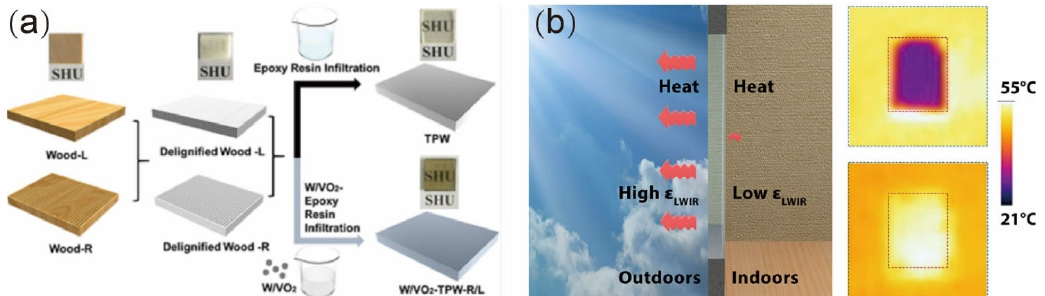
Figure 6. Functional transparent composite materials for energy-saving windows. ( a ) Schematic description of the synthesis route of tungsten-doped vanadium dioxide nanoparticles impregnated into a delignified wood template in the longitudinal or radial directions (W/VO 2 -TPW-R/L) [70]. ( b ) Schematic demonstration of the working mechanism of radiative cooling (RC) cellulose glass [75]. (( a ) Reproduced with permission from Zhang et al. [70]. Copyright 2020 ACS Publications; ( b ) Repro- duced with permission from Zhou et al. [75]. Copyright 2021 ACS